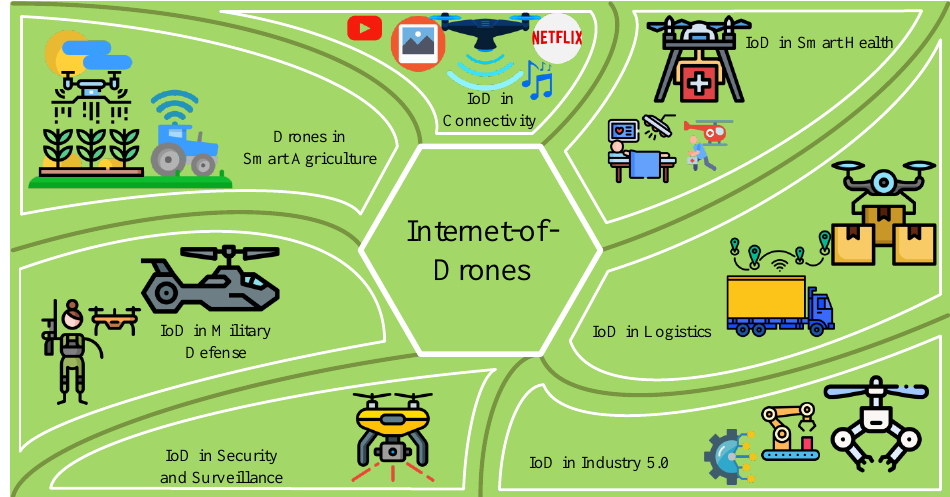
Figure 1. Internet-of-Drones and its